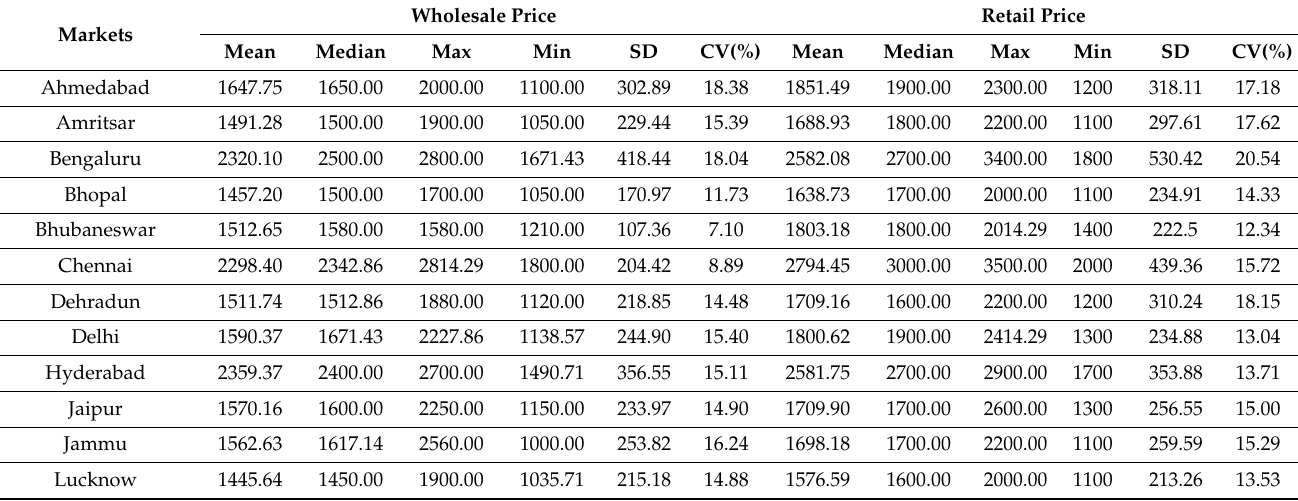
Table 1. Descriptive statistics for the wholesale and retail prices (INR per quintal) of the individual